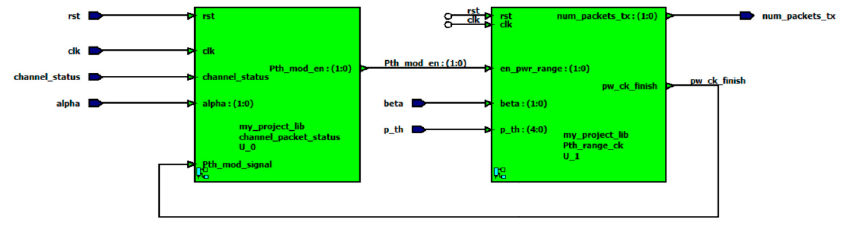
Figure 10. Block diagram of the proposed channel aware scheduler.